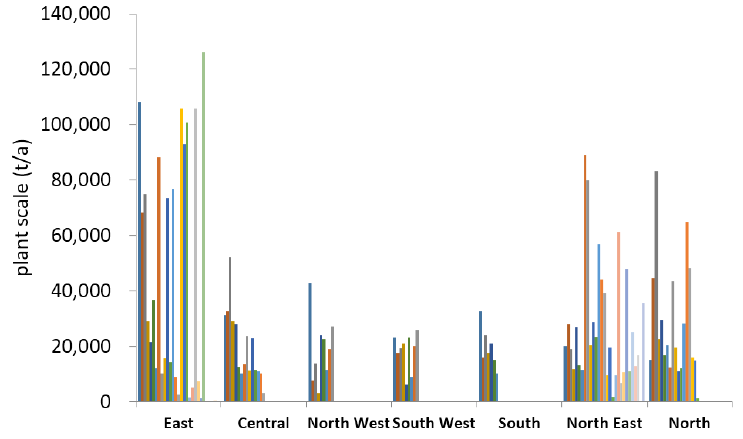
Figure 5. Regional plant scale distribution. Table 3. Plant scale distribution and regional average